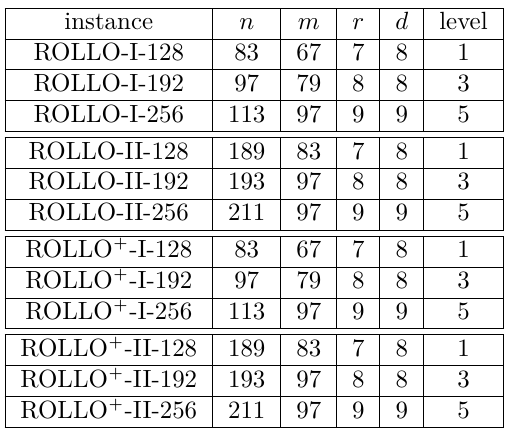
Table 1: Parameter sets of ROLLO and ROLLO ` .